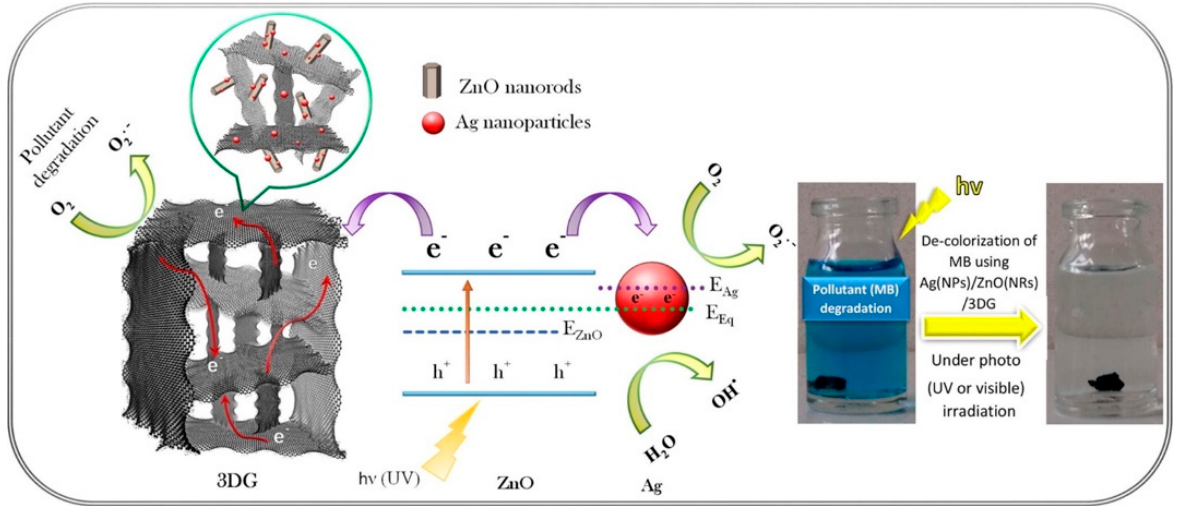
Figure 7. Mechanism of action of photocatalytic degradation of methylene blue dye by Ag/ZnO/3DG graphene structure. Reprinted with permission from Ref. [114]. Copyright 2019, Elsevier.